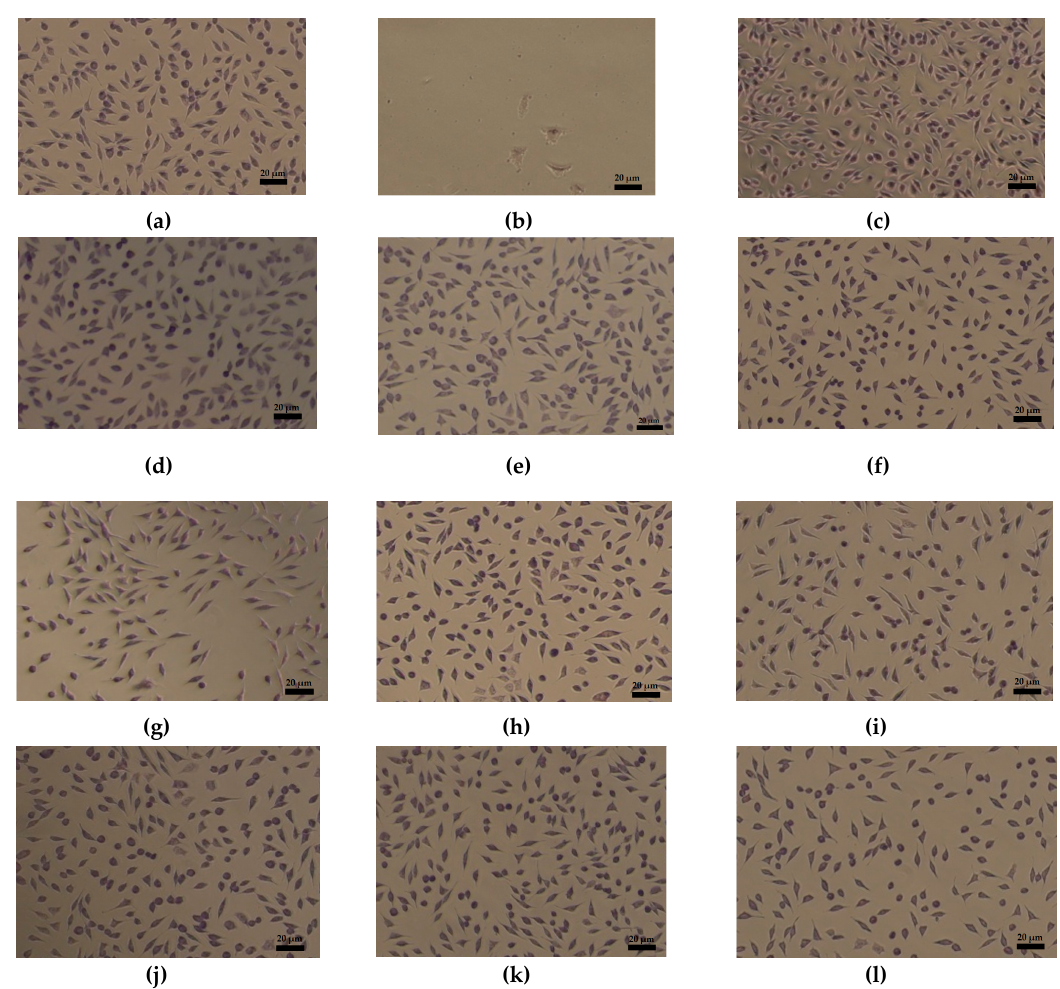
Figure 8. Cellular morphology after interaction of the fibroblast cell line (NCTC clone L929) with different concentrations of collagen-based nanofibers (magnification 20×, scale bar 20 μ m). Culture control ( a ); positive control ( b ); Col nanofibers at concentrations of 100, 500, and 1000 μ g/mL ( c – e ); Col/ZnO NPs nanofibers at concentrations of 500 and 1000 μ g/mL ( f , g ); Col/TiO 2 -N-Ag NPs nanofibers at concentrations of 750 and 1000 μ g/mL ( h , i ); and Col/CS nanofibers at concentrations of 500, 750, and 1000 μ g/mL ( j – l ) for 48 h (Giemsa staining).